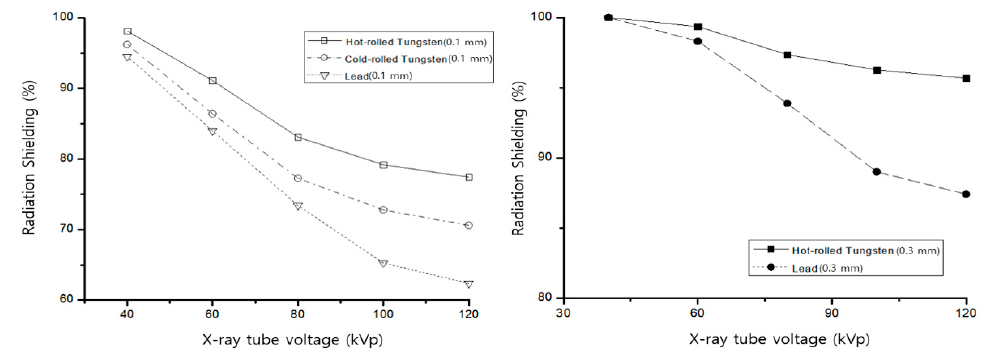
Figure 6. Comparison of shielding performance between the manufactured thin-film tungsten plate and lead.